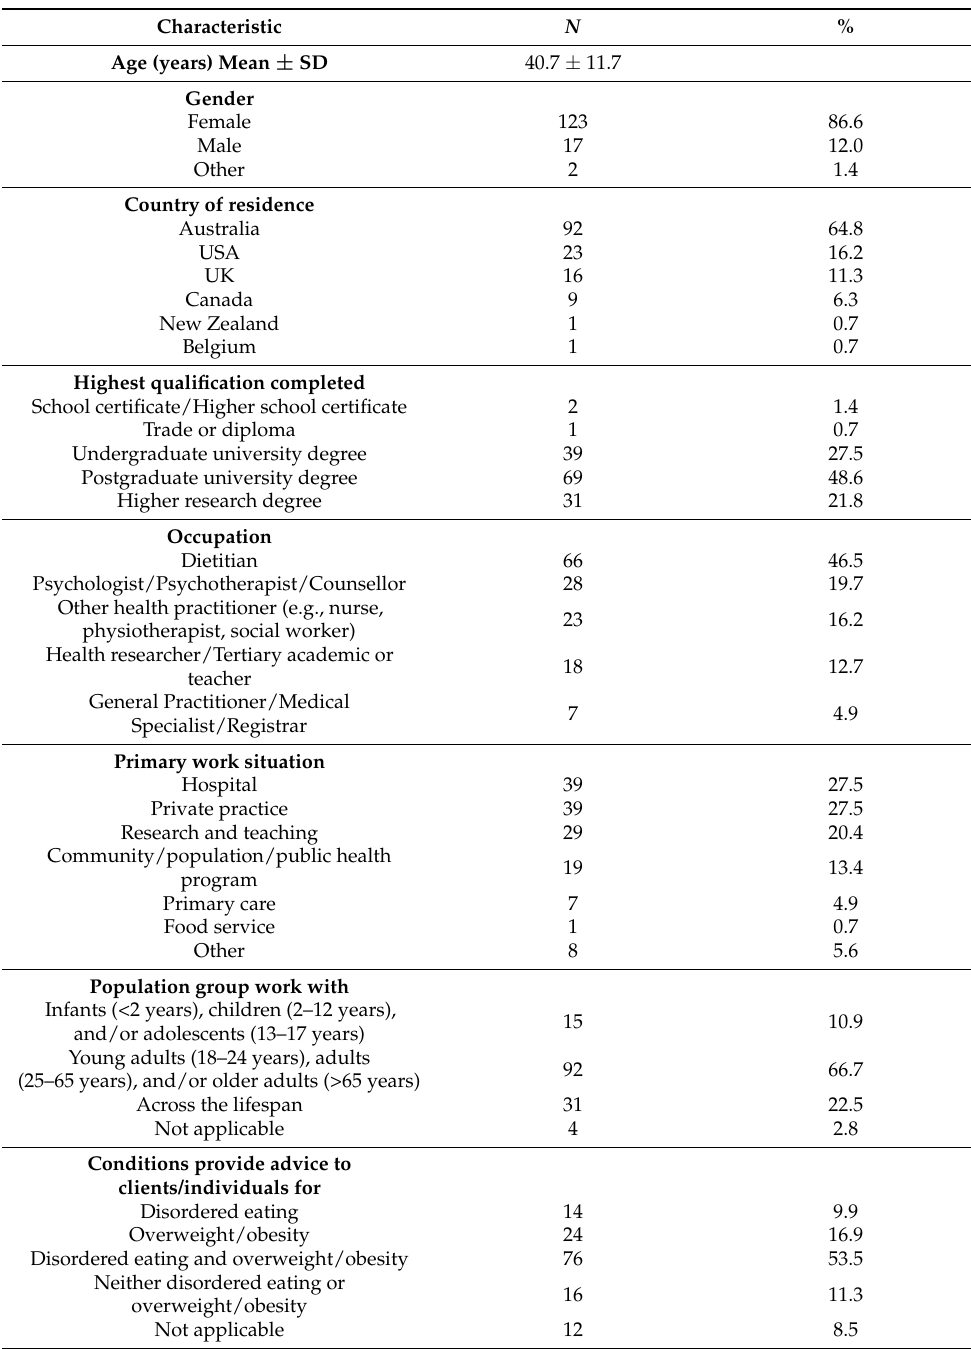
Table 1. Demographic characteristics of health professionals participating in a survey on addictive eating ( n =